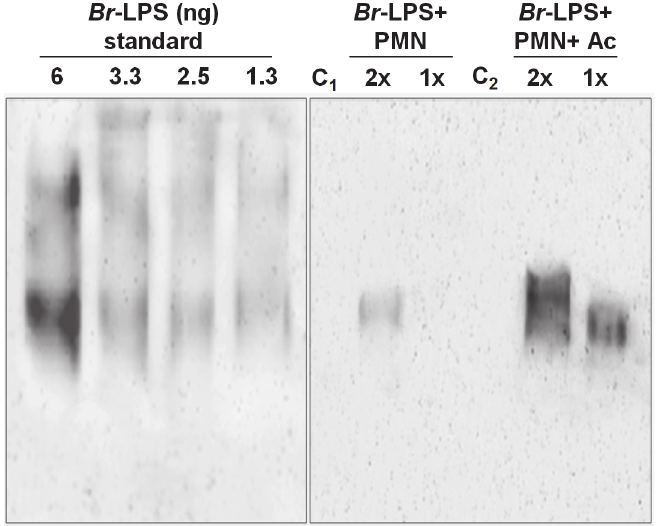
Fig 7. Quantities of Br -LPS interacting with PMNs. The quantities of Br -LPS associated to PMNs were determined by Western blotting using a monoclonal antibody against Br -LPS conjugated with peroxidase enzyme. All wells were loaded with 15 μ L of the respective preparation. The amounts of purified Br -LPS in the left panel were used to estimate the quantities based on a standard curve ranging from 0.06 ng to 12 ng (only wells from 1.3 – 6 ng are shown). The right panel corresponds to the assay: purified PMNs were incubated with Br -LPS and the associated amounts determined by Western blot (Br-LPS+PMNs). In order to have